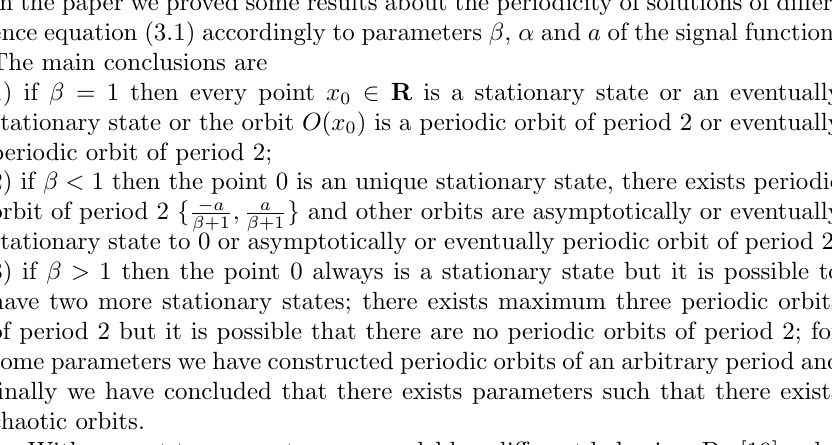
Figure 11. a)Invariant set of function h is interval [0 ,B ] where B ∈ [ αβ, a function h does not exist invariant